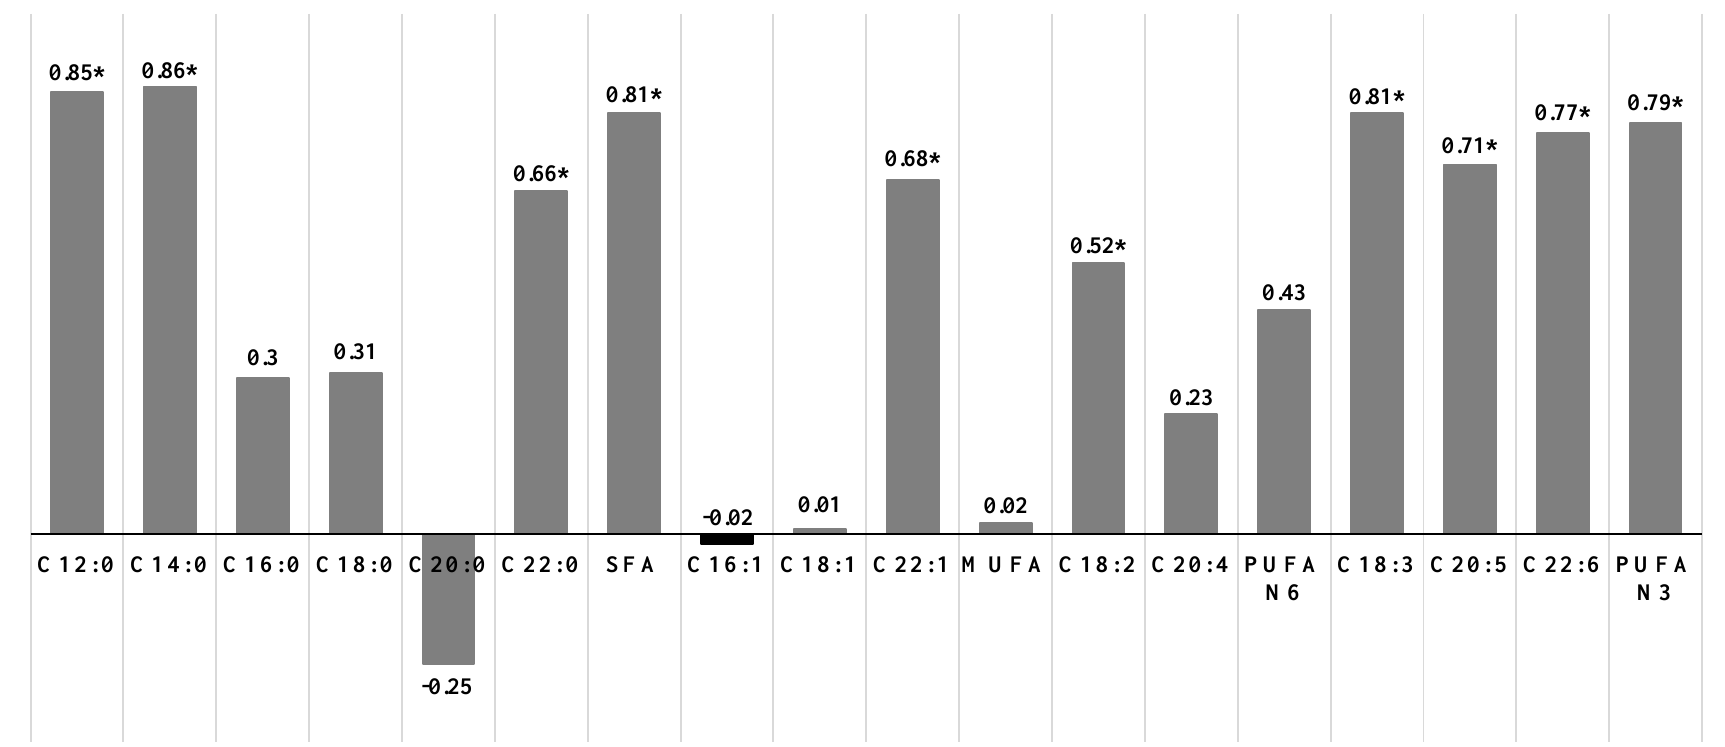
Figure 1. Correlation coefficients between fatty acid content in the diet and the content of the same fatty acids and the iodine value in meat ( longissimus m.) . (* correlation statistically significant at p ≤ 0.05).